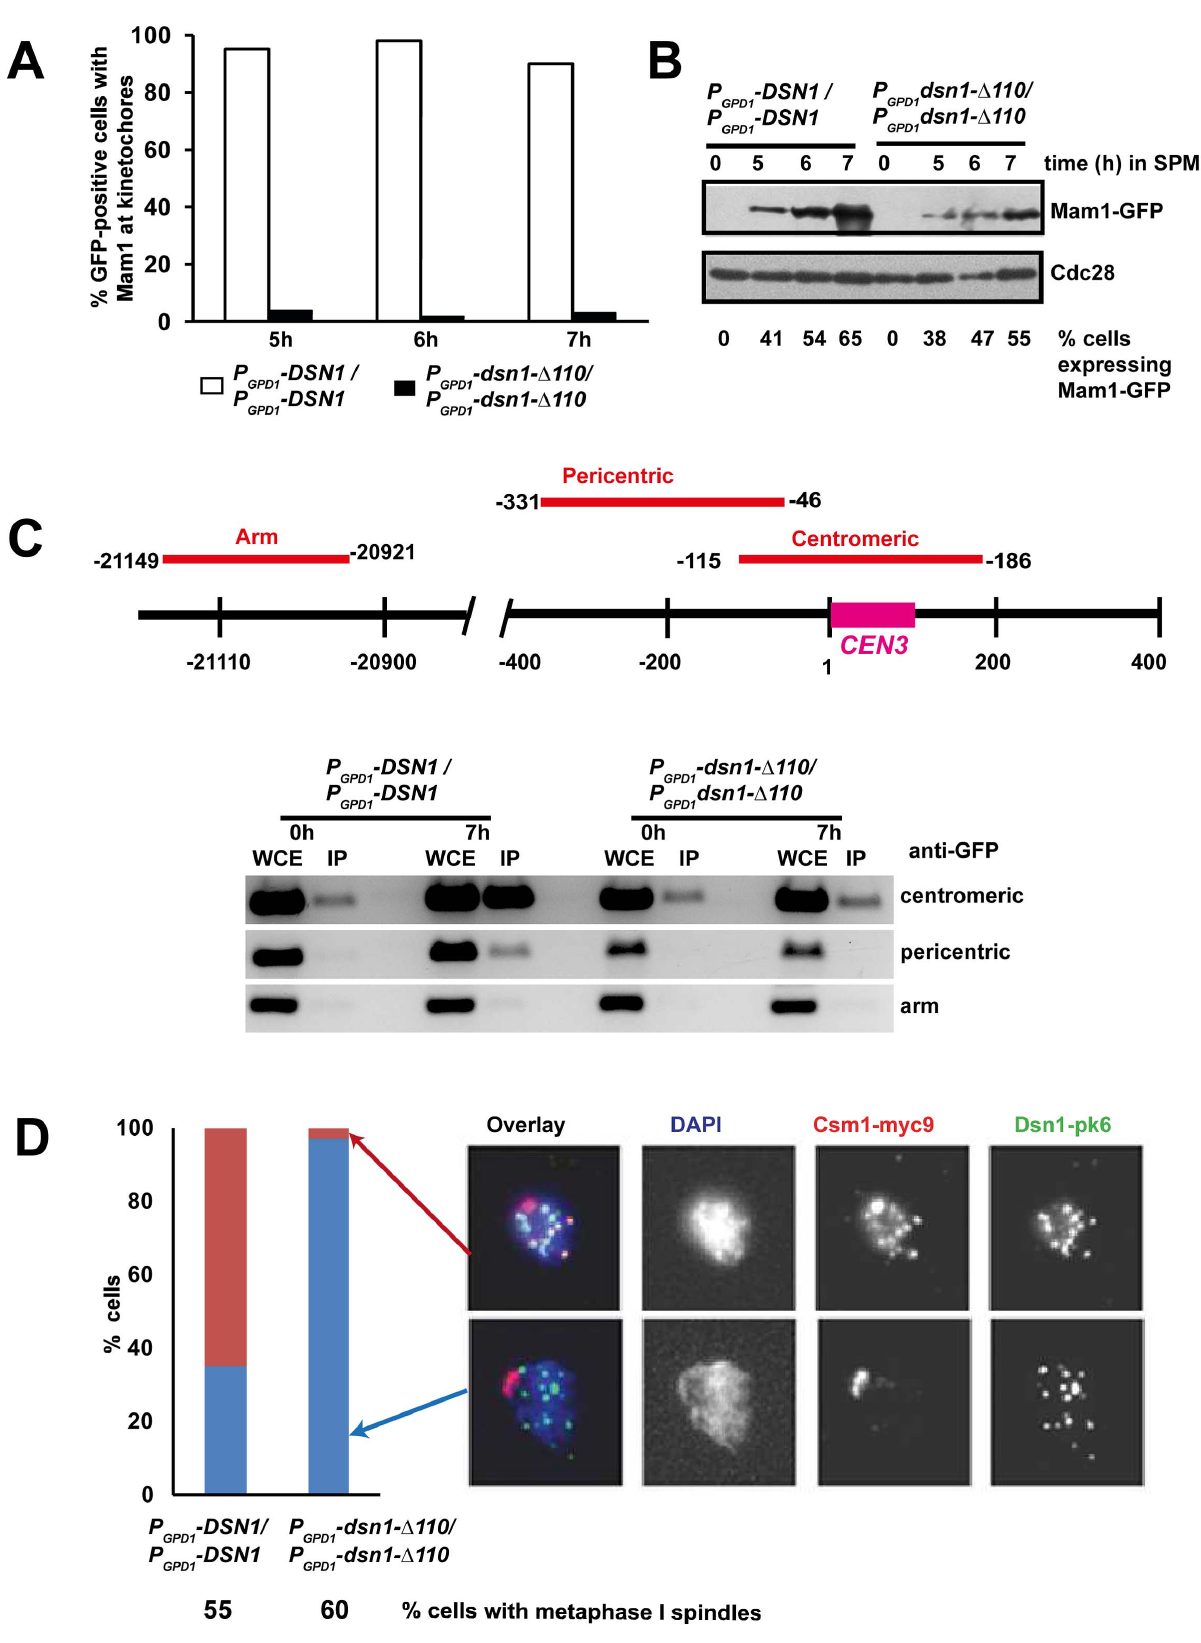
Figure 5. The Csm1-Interaction Domain of Dsn1 is required for monopolin association with kinetochores. MAM1-GFP MTW1-RFP P CLB2 - CDC20 cells expressing either DSN1 or dsn1- D 110 were induced to enter meiosis. Mam1 association with kinetochores was measured using GFP fixation assay and Chromatin Immunoprecipitation (ChIP). A) Percentage of cells showing co-localization of Mam1-GFP signals with Mtw1-RFP signals PLOS Genetics |